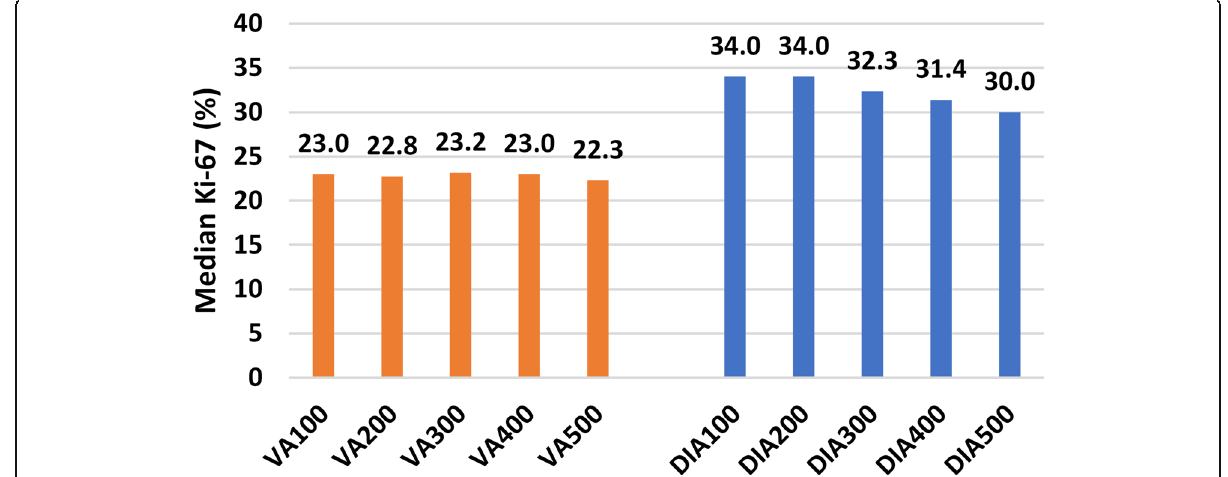
Fig. 5 Median Ki-67 at each cumulative 100-cell increment for visual assessment (VA) and digital image analysis